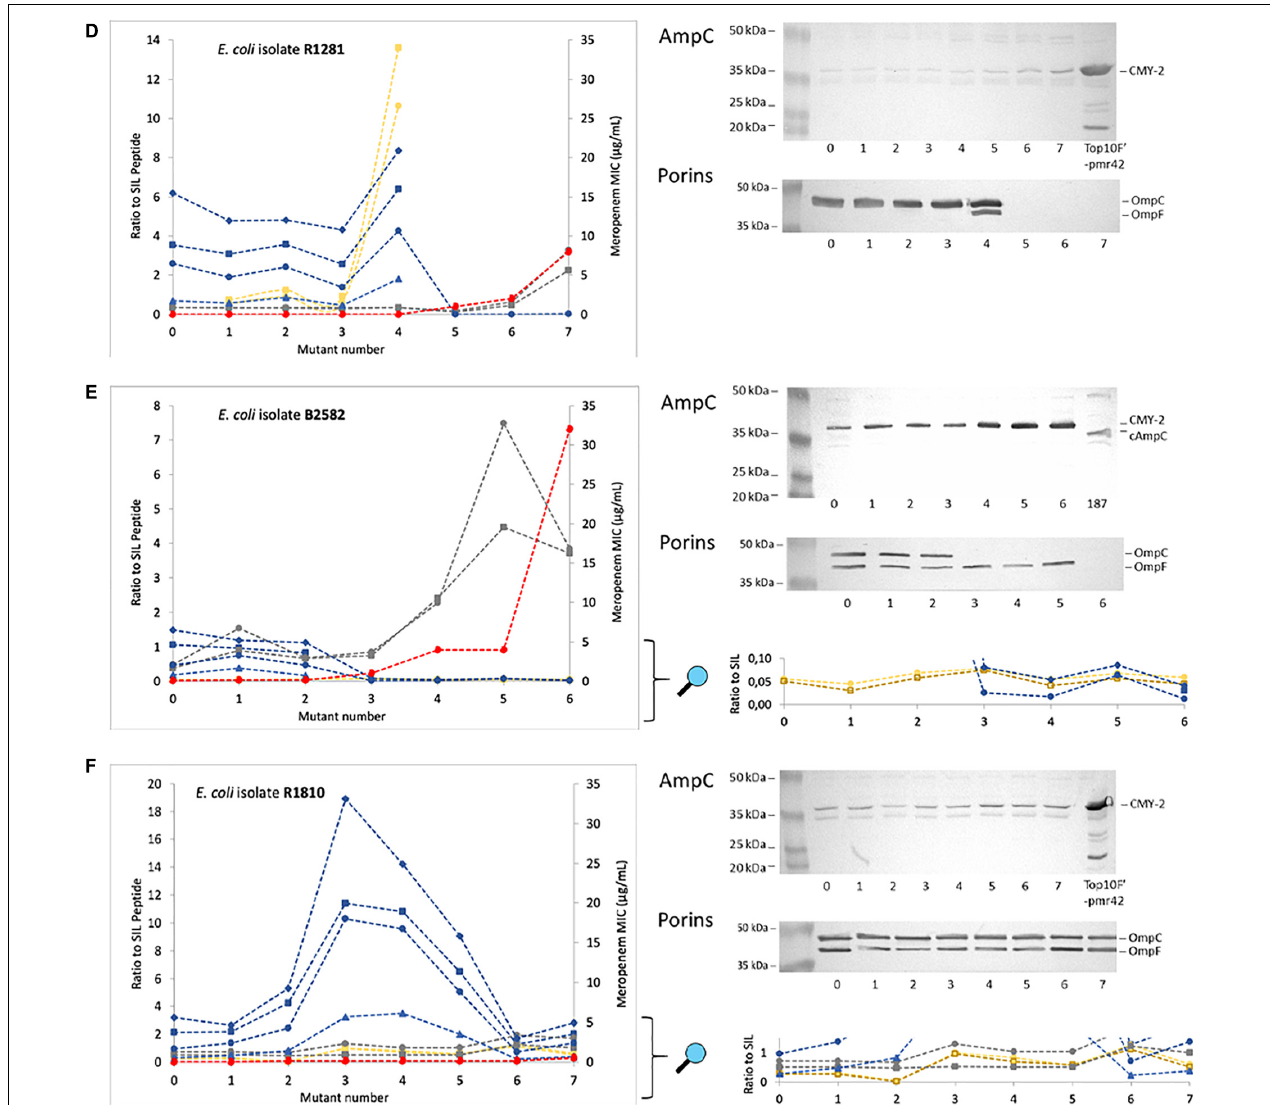
FIGURE 2 | Analysis of the presence of CMY-2-like, cAmpC, and the porins OmpC and OmpF in mutant isolates of different E. coli strains selected under increasing meropenem concentrations using LC-MS/MS and Western blotting. On the Y-axis the meropenem minimum inhibitory concentration and mass spectrometry signal intensity of each endogenous peptide divided by signal intensity of each stable isotope labeled (SIL) peptide. When a peptide was not detected in a mutant isolate, the corresponding symbol was left out. All detected peptides were shown even when ratios to SIL approached zero. Molecular weight standard proteins are indicated (in kDa) at the left of the blots. Strains Top10F’-p2761 and Top10F’-pmr42 were used in the Western blot analysis as positive controls for CMY-2 and strain 187 as a positive control for cAmpC. (A–F) Represent the different clinical strains referred to throughout the “Results”